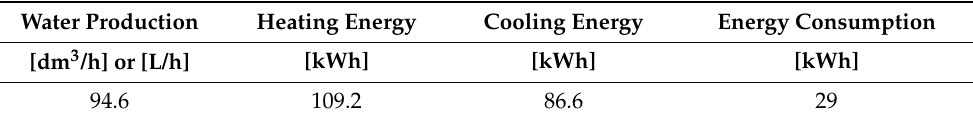
Figure 3. Integrated machine average hourly behaviour, month by month. Table 2. AWG ‐ integrated machine hourly behaviour averaged over the year, expressed as water production, heating, cooling energy and energy consumption.